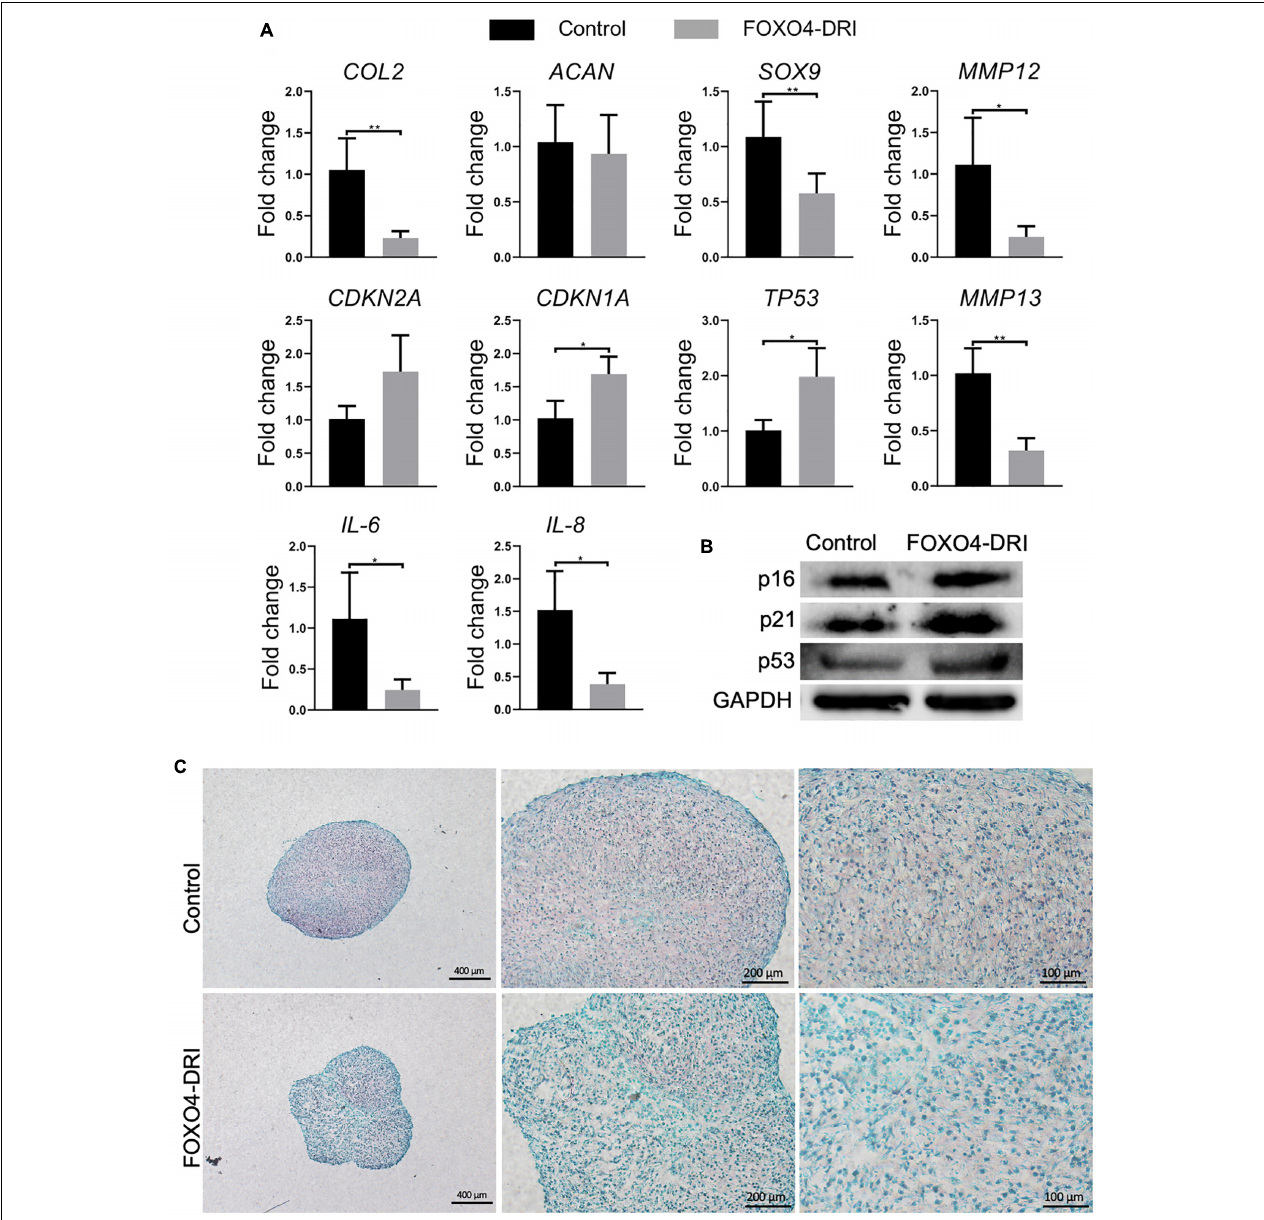
FIGURE 3 | Assessment of senescence level and chondrogenesis in engineered cartilage. PDL9 were pretreated with (FOXO4-DRI) or without (Control) FOXO4-DRI for 5 days and then subjected to 14 days of chondrogenic cultures. (A) Expression levels of selective genes. The data was normalized to that in the Control group (set as 1). (B) Western blot. (C) Safranin O/Fast green staining. Bar = 400, 200, and 100 µ m from the left to right. * p < 0.05; ** p <